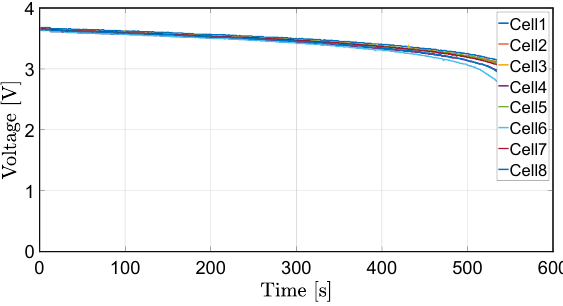
Figure 16. The discharging process of the cells with balancing circuit.